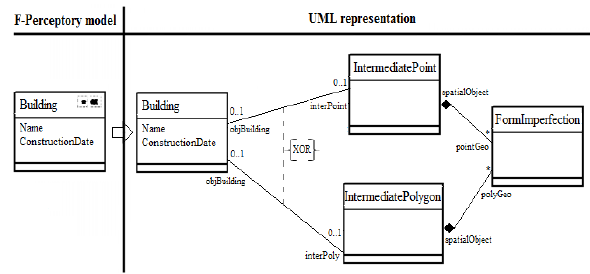
Figure 10. Fuzzy alternative geometry mapping